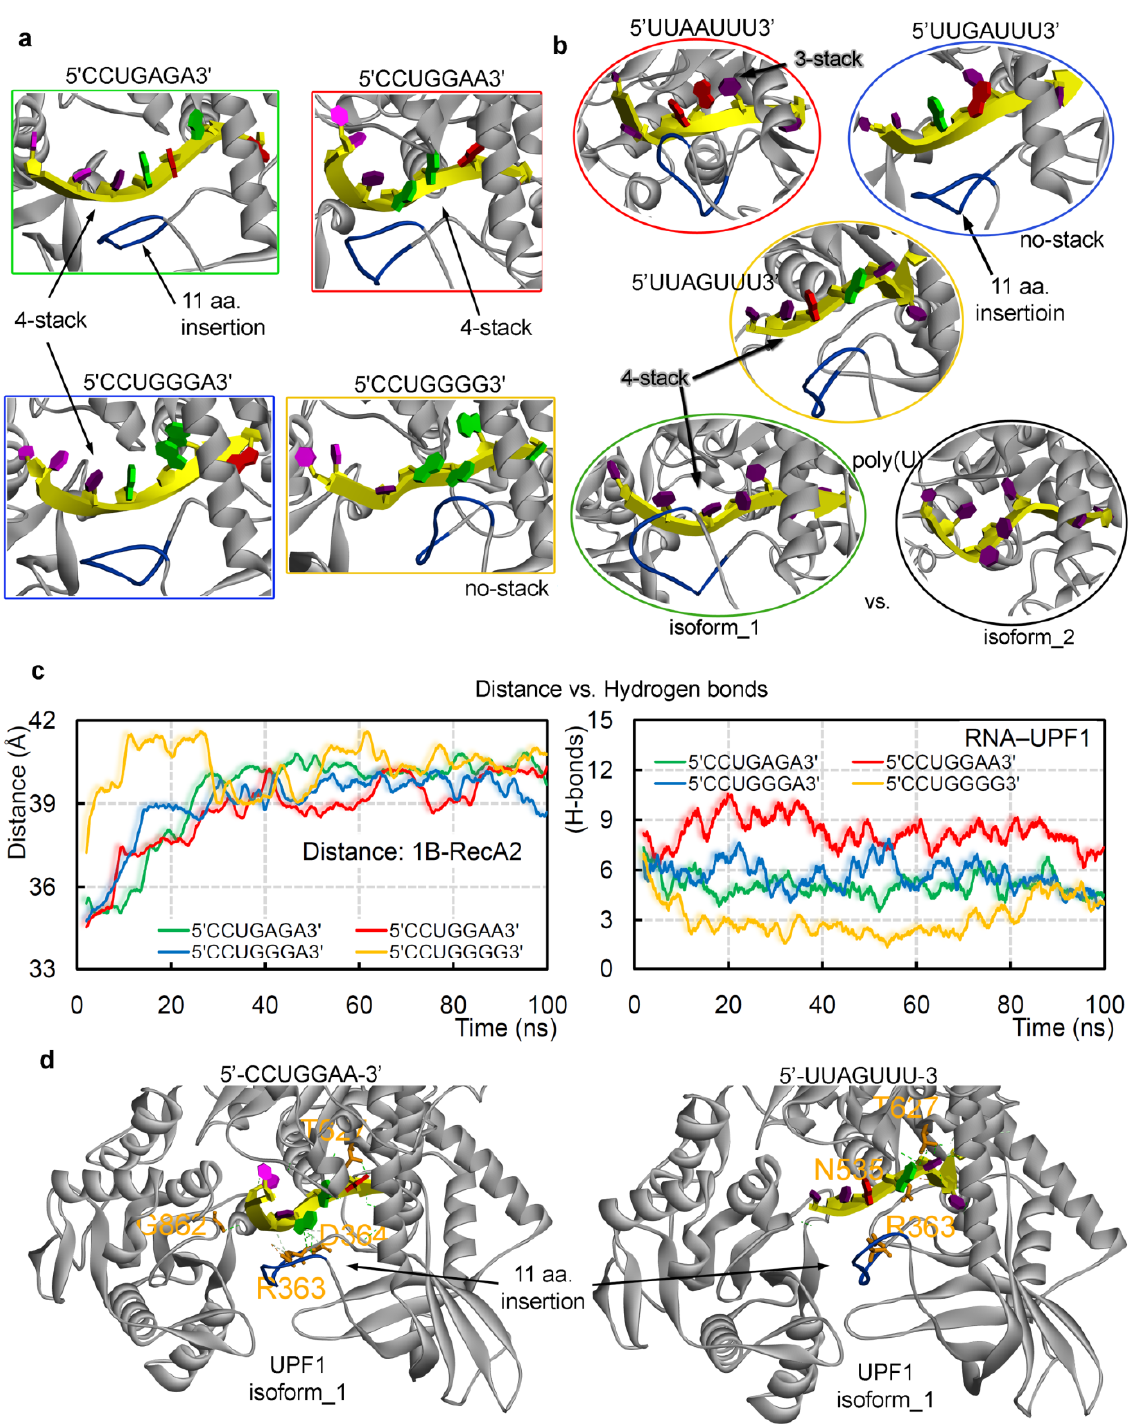
Figure 4. The dynamics of different UPF1 ‐ mRNA simulated systems. The ( a , b ) stacking pattern interactions formed by different GC ‐ and AU ‐ rich mRNA motifs with UPF1 isoforms and averaged structures retrieved from the 100 ns MD simulations are presented. For UPF1 isoform_1, the insertion 353 ‐ GNEDLVIIWLR ‐ 363 is marked in blue color. ( c ) The distance center of mass computed between 1B and RecA2 domains of UPF1 isoform_1 with GC ‐ rich mRNA motifs (left panel), as well as the UPF1 ‐ mRNA intermolecular hydrogen bond interactions (right panel). ( d ) UPF1 isoform_1 residues that were found common, as well as those making high occupancy ( ≥ 50 ns) interactions with GC ‐ rich motifs (R363, D364, T627, and G862) or AU ‐ rich motifs (R363, N535, and T627). As an example, the 5 ′‐ UUAGUUU ‐ 3 ′ and 5 ′‐ CCUGGAA ‐ 3 ′ motifs are represented with the UPF1 protein. Nucleotide color scheme; adenine (A) in red color, uracil (U) in dark purple, cytosine (C) in light purple, and guanine (G) in green.